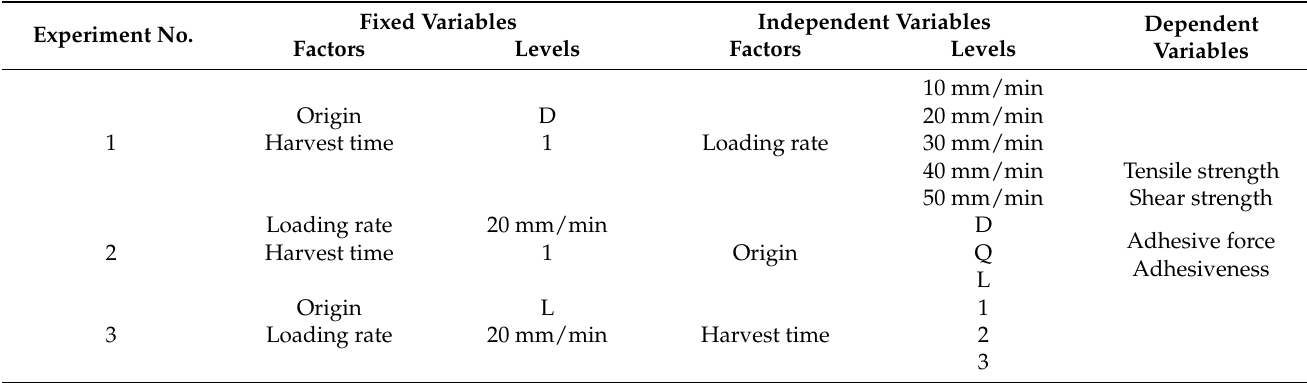
Figure 3. Samples used in tensile and shear experiments. Table 1. Factors and levels of mechanical properties